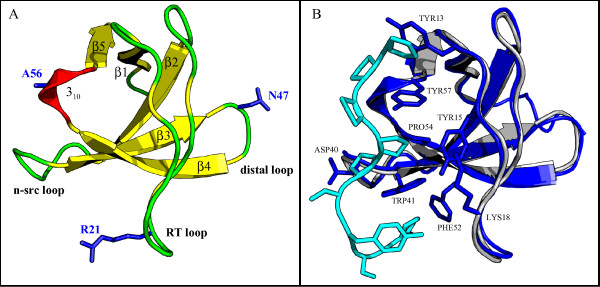
Cartoon representations of the Spc-SH3 domain. A) X-ray structure of WT Spc-SH3 (PDB code: 1SHG). Secondary structures are attributed according to the DSSP program (β-strands: yellow; 310 helix: red; loops: green) and labelled according to the generally adopted nomenclature for SH3 domains. The three mutated residues are shown as blue sticks. B) Structure of the R21A Spc-SH3:p41 complex (PDB code: 2JMA), in blue, superimposed to the WT Spc-SH3 structure in grey. Residues that interact with the ligand are shown as sticks. The structure of p41 is shown in cyan.